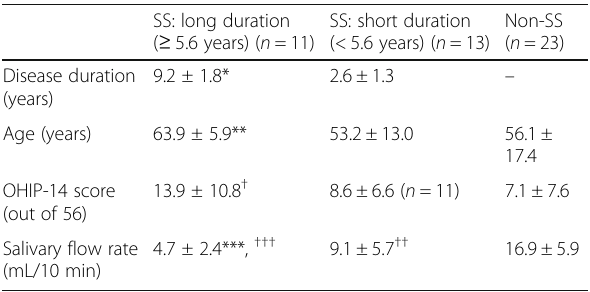
Table 1 Clinical characteristics of the study groups